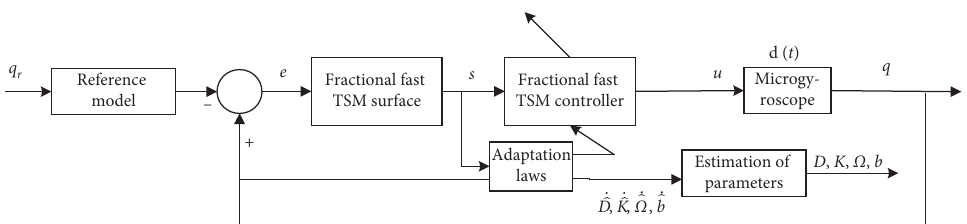
Figure 2: The block diagram of the robust adaptive fractional fast TSM